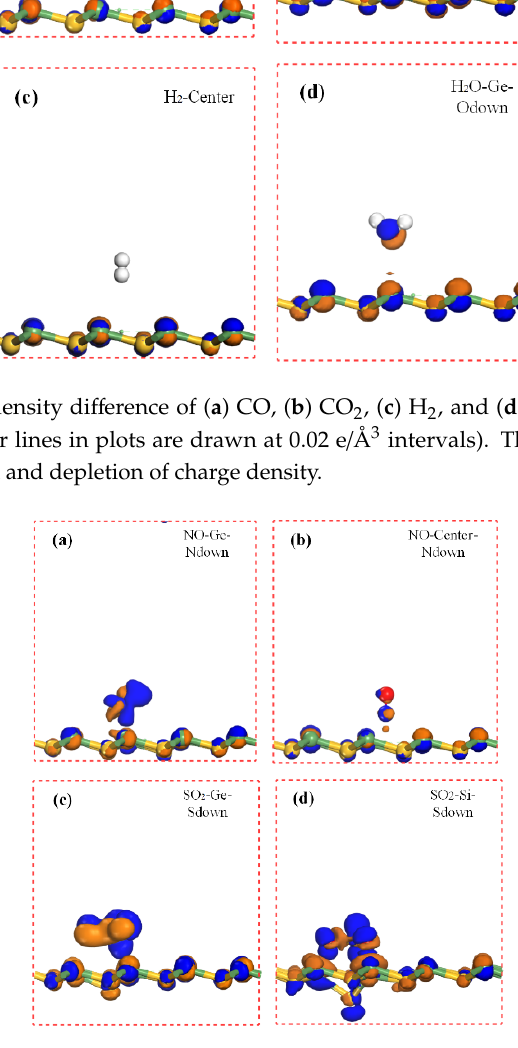
Figure 7. The charge density difference of NO (Figure ( a ) shows NO on Ge site and ( b ) shows NO on Center site) and S 2 O (Figure ( c ) shows SO 2 on Ge site and ( d ) shows SO 2 on Si site) adsorbed on SiGe monolayer.